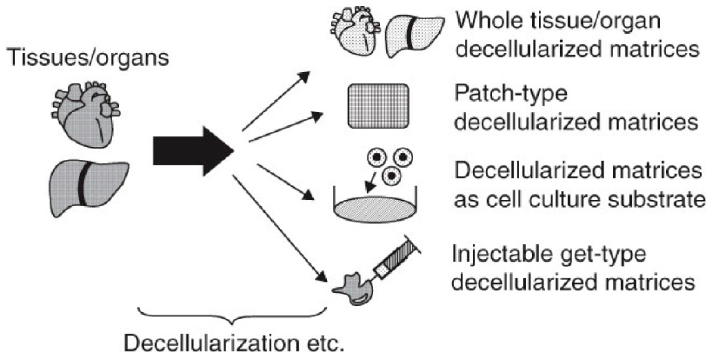
Figure 6. Different applications of decellularized matrices from tissues and organs. Reprinted from [63]. Copyright (2010) Informa UK Limited.